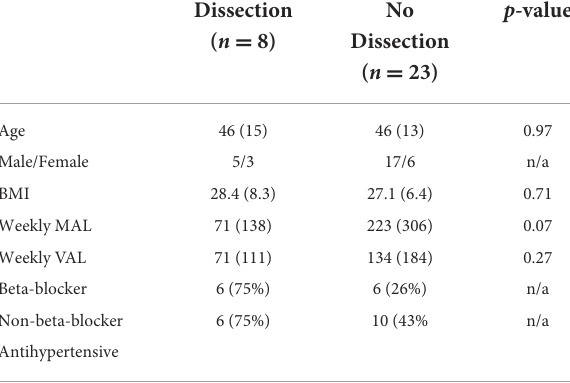
TABLE 2 Demographic characteristics of TAD cases stratified by history of aortic